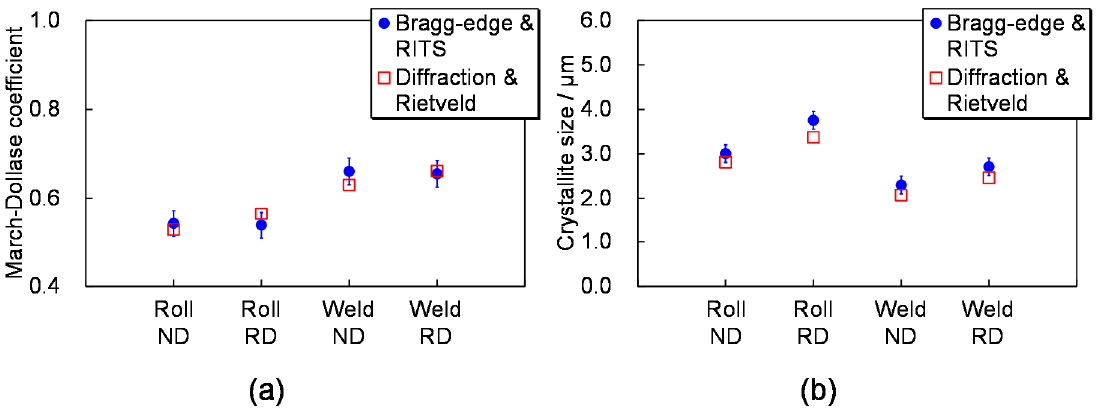
Figure 7. Comparison between Bragg-edge neutron transmission method with the RITS code and neutron diffraction method with the Rietveld analysis: ( a ) March-Dollase coefficient (degree of texture evolution) and ( b ) crystallite size [2,7,36].